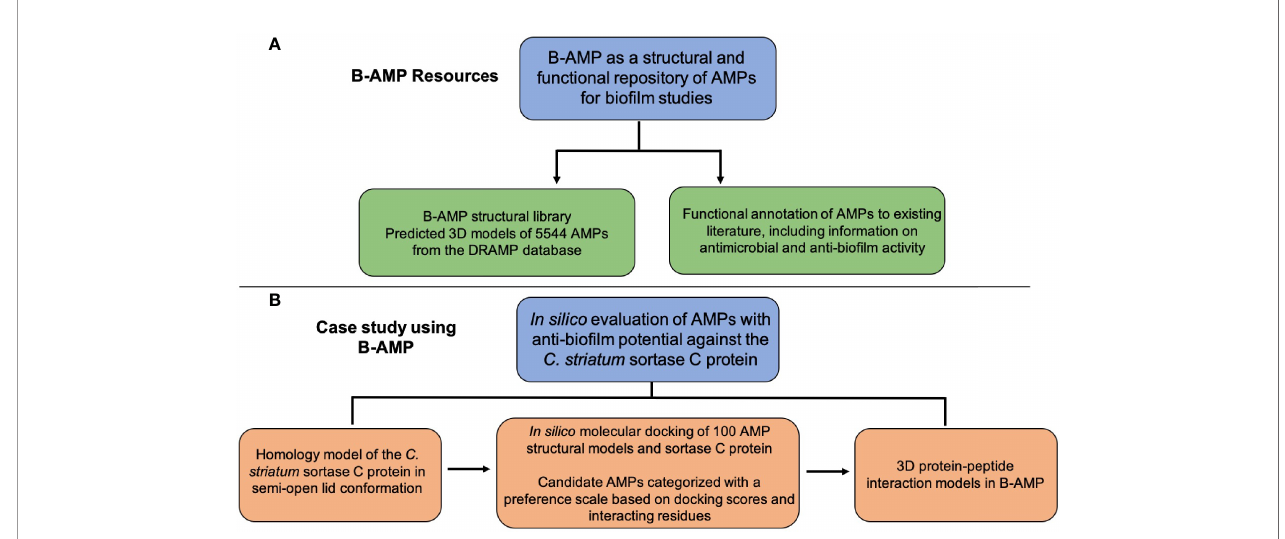
FIGURE 6 | Resources in B-AMP and a case study to demonstrate the usability of B-AMP to identify AMPs with anti-bio fi lm potential. (A) The resources and data generated in this approach are freely available in Bio fi lm-AMP (B-AMP), a user-friendly, search-enabled repository of AMP structures and AMP interactions with bio fi lm targets. B-AMP also includes annotations of AMPs to existing bio fi lm literature sources (B) To demonstrate the feasibility of B-AMP for in silico evaluation of AMPs with anti-bio fi lm potential, we present a case study using the emerging pathogen C. striatum . For this, we used a combination of homology modeling, predictive peptide modeling and protein-peptide molecular docking, and suggest a preference score based on which candidate AMPs could be taken up for further